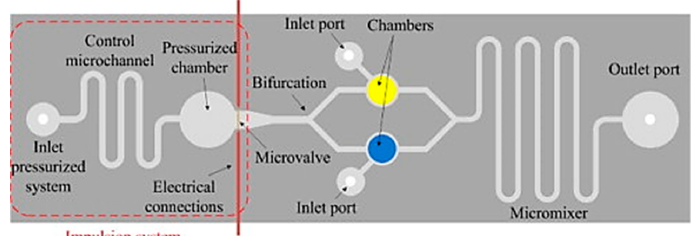
Figure 3. Schematic for a portable microfluidic platform composed of printed circuit board (PCB) technology with SU-8 photoresist. Schematic shows the impulsion system containing inlet, automated microchannels, and pressurized chambers combined with electronics followed by micromixer serpentine design and sample outlet. (Re-printed from Aracil et al. [61]. Copyright (2015), with permission from Elsevier).